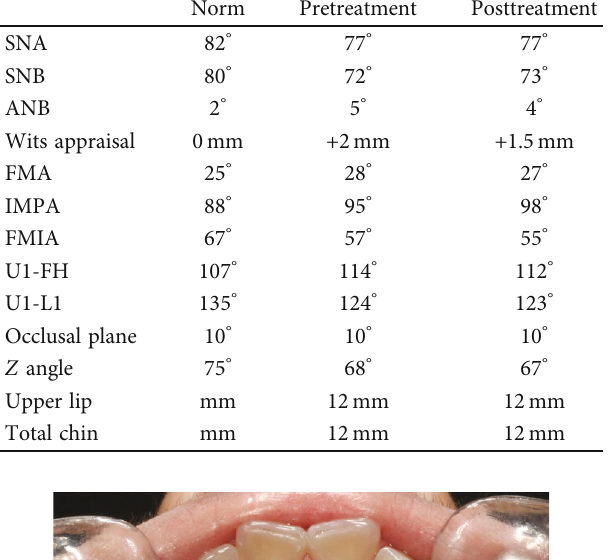
Table 1: Case 1 cephalometric